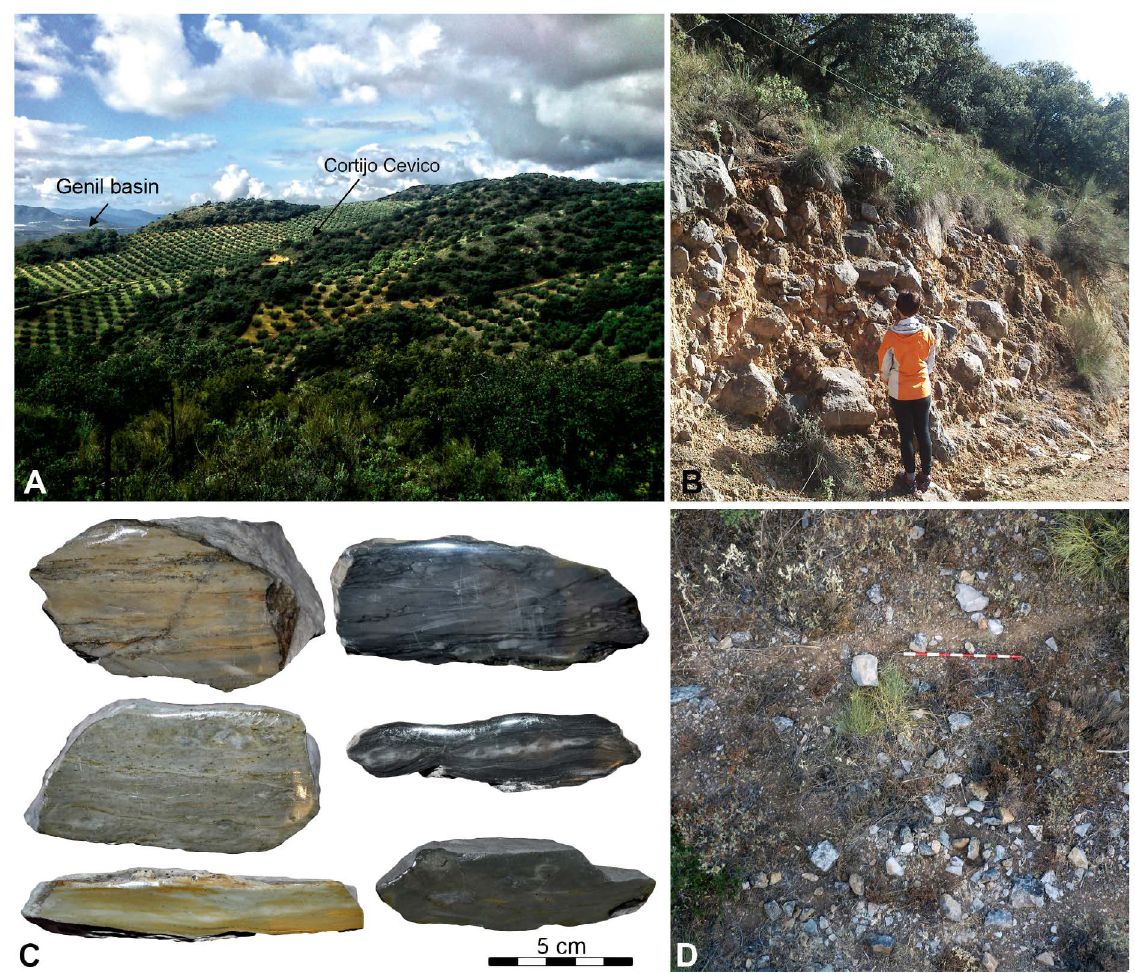
Figure 2. Geographical and geological context of the quarry. A. The outcrop situation in the basin of Genil; B. The outcrop aspect in the cutting of a path; C. Aspect of dolomitic marble after polishing and D. Surface of the